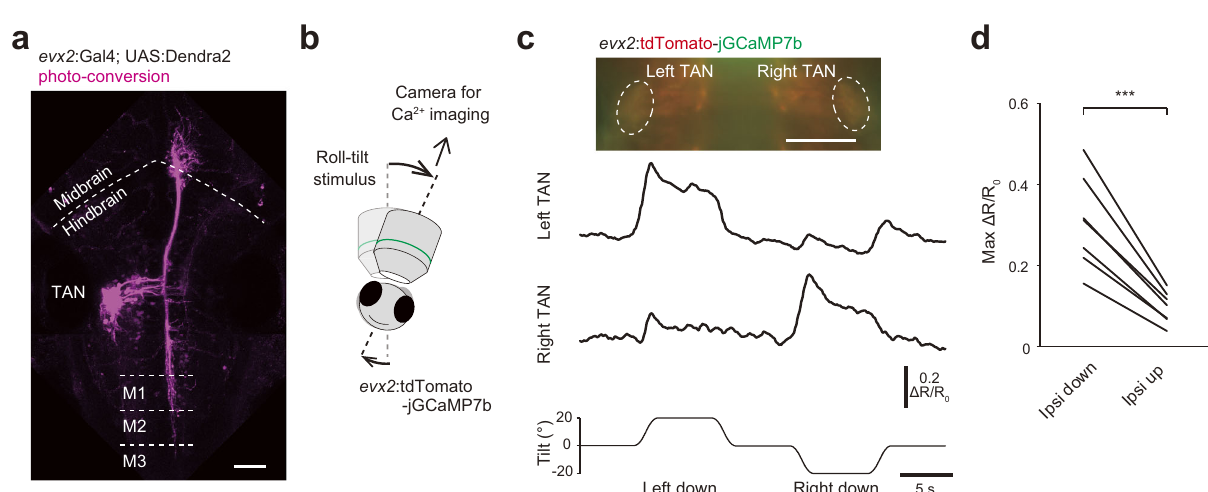
Fig. 4 | Ca 2+ imaging of TAN neurons during roll tilts. a TAN neurons photo- converted from green to red in Tg( evx2 :Gal4; UAS:Dendra2) at 5 dpf. Confocal stacked image (maximum intensity projection). M1, M2, and M3 indicate the fi rst, second, and third muscle segments, respectively. b Schematic of Ca 2+ imaging experiments. A fi sh embedded in agarose is imaged using a tiltable objective microscope. c Top: image of a Tg( evx2 :tdTomato-jGCaMP7b) fi sh.